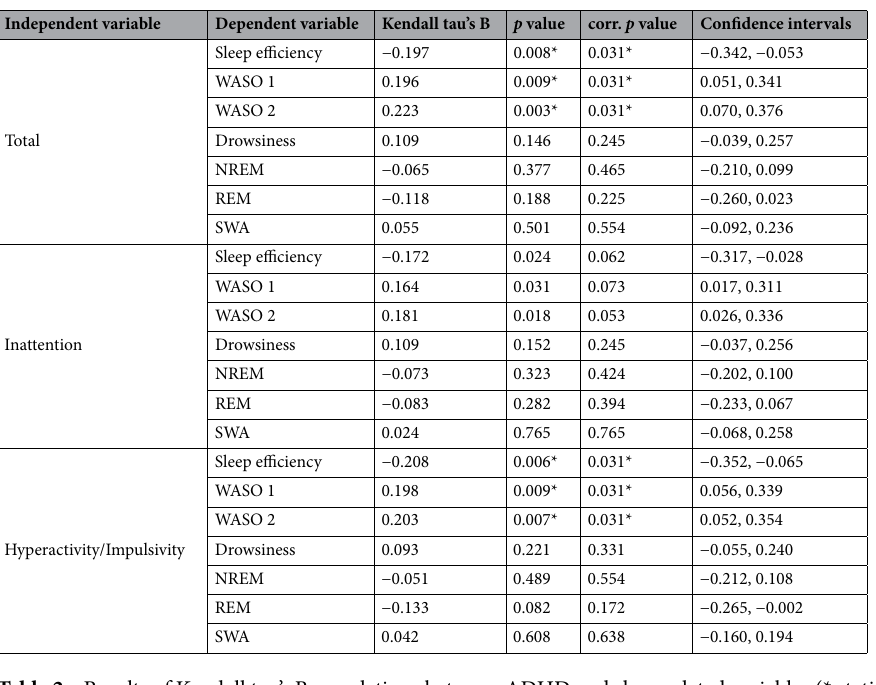
Table 2. Results of Kendall tau’s B correlations between ADHD and sleep related variables (* statistically significant).